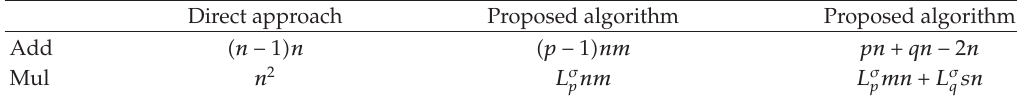
Table 1: Computation complexity of the fast algorithm based on Pauli block matrices. For simplicity, Add and Mul denote the number of additions and multiplications. The notations L σ of nonidentity matrices σ 0 in Pauli block matrices Q p and Q q .